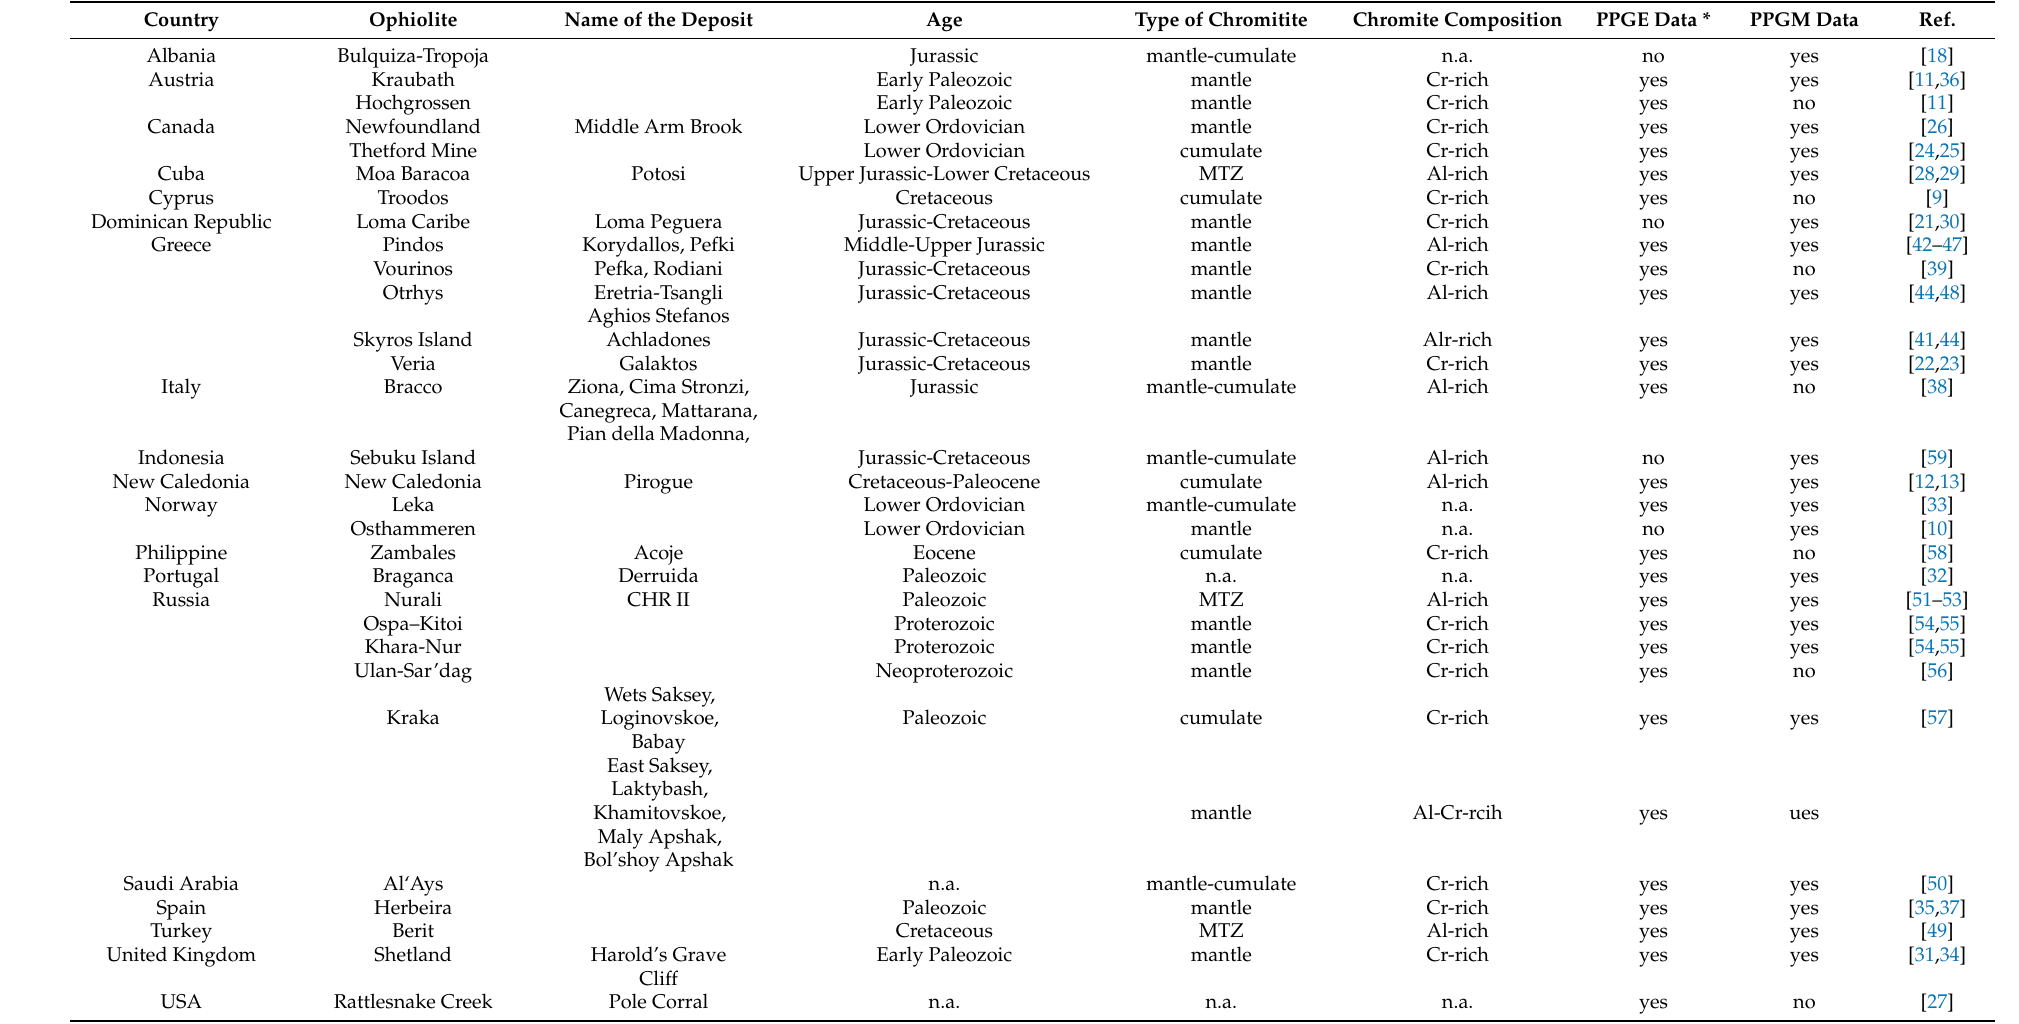
Table 1. World-wide occurrences of PPGE-PPGM-rich ophiolitic chromitites (listed in alphabetical order according to the host